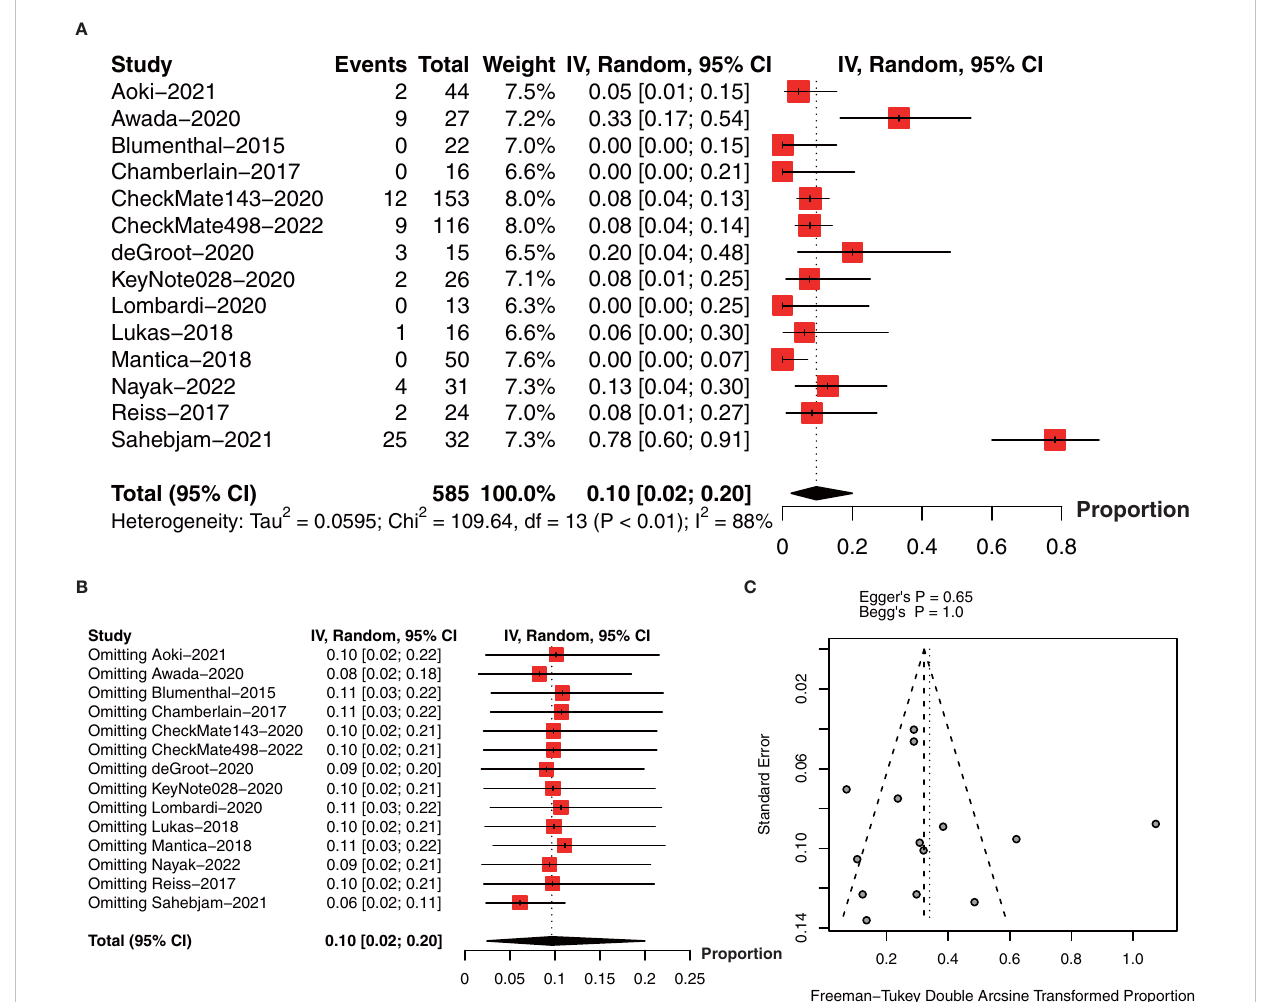
FIGURE 7 (A) The pooled estimate of ORR. (B) sensitive analysis of ORR. (C) funnel plot of median ORR. ORR, objective response